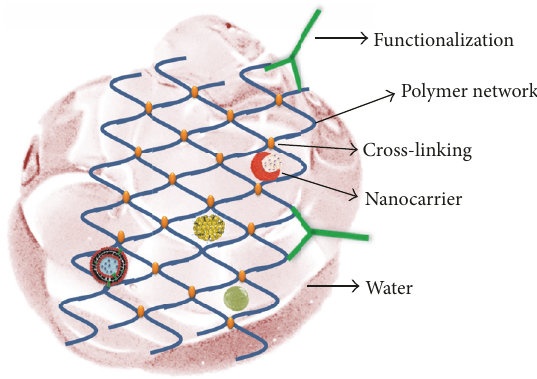
Figure 1: Hydrogels are semisolid pharmaceutical forms composed mostly of water, tridimensional polymeric network, and cross- linked chains. Their hybridization process allows incorporating other functional groups, drug-loaded nanocarriers, and triggers, improving the DDS